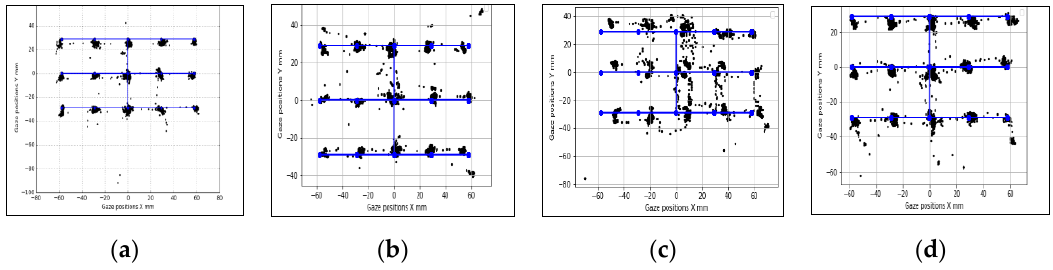
Figure 12. Data from head pose experiments: ( a ) neutral, ( b ) roll +30, ( c ) pitch +20, and ( d ) yaw +30 degrees.